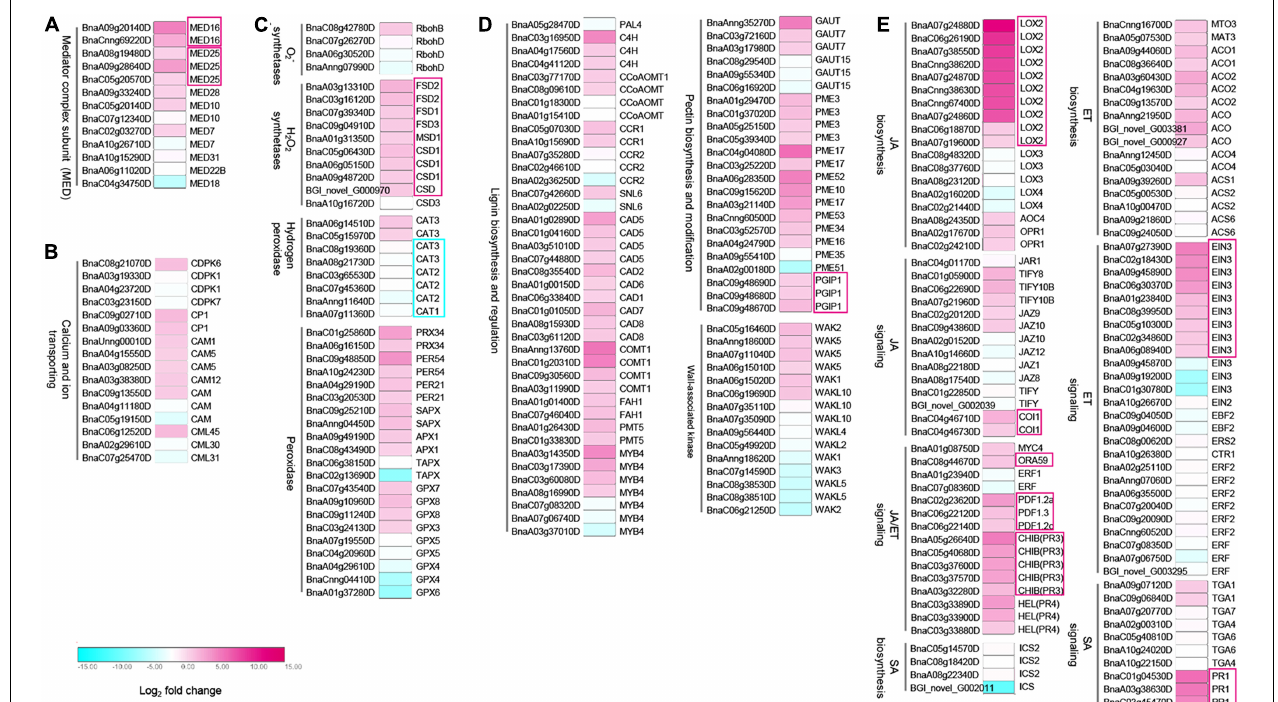
FIGURE 3 | Differentially expressed genes (DEGs) between B. napus transgenic and WT lines in response to S. sclerotiorum infection. Heatmap of DEGs related to S. sclerotiorum infection B. napus seedling leaves of mediator genes (A) , Ca 2 + -mediated signal transduction related genes (B) , ROS related genes (C) , plant cell wall-related genes (D) , and JA/ET synthesis and signal pathway regulated genes (E) . DEGs were considered statistically significant if q -value < 0.005 and | log 2 -fold change| > 1. The log 2 -fold change is indicated according to the scale bar. The color from cyan to magenta represents the DEGs from down-regulated to up-regulated. The intensity of the color indicates the multiple of change for DEGs, with a darker color meaning higher fold change. The common up-regulated DEGs are highlighted by red boxes. Details of the genes are given in Supplementary Dataset 1 .